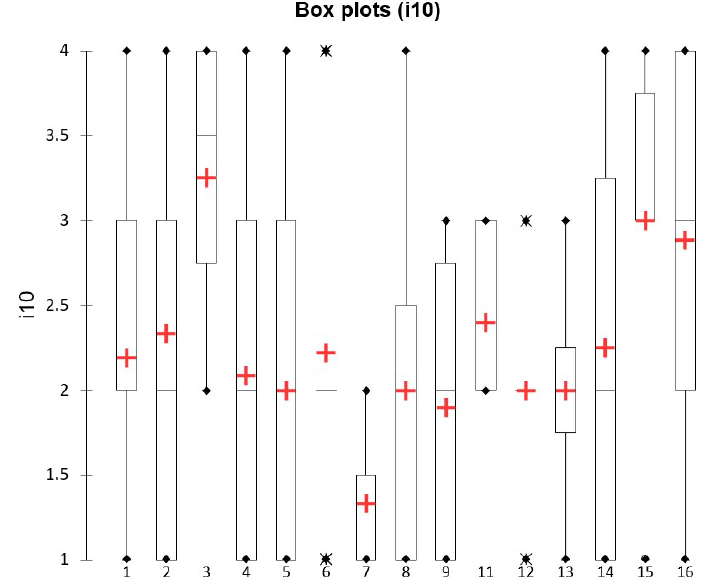
Figure 10. Box plots of the average scores of Item 10 (presentation of contents addressed) according to the typology of the program.